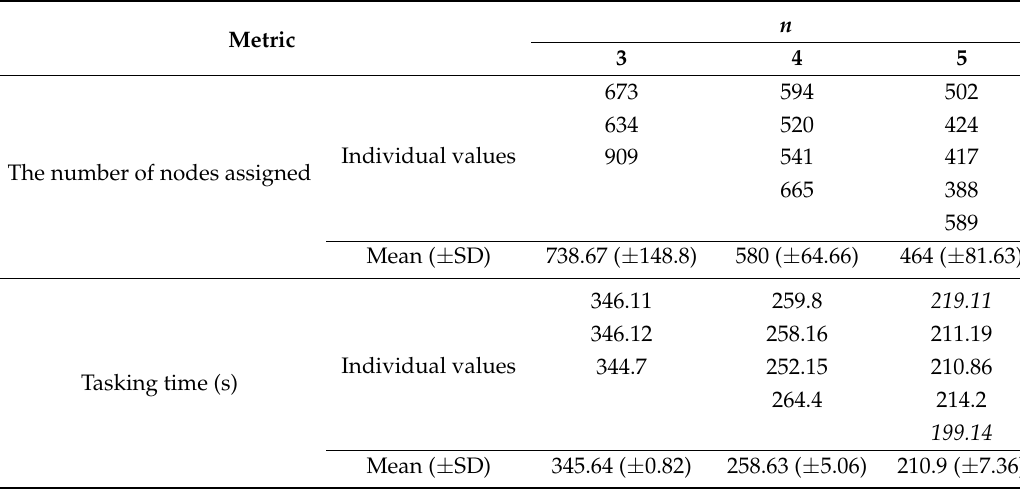
Table 2. Results of the